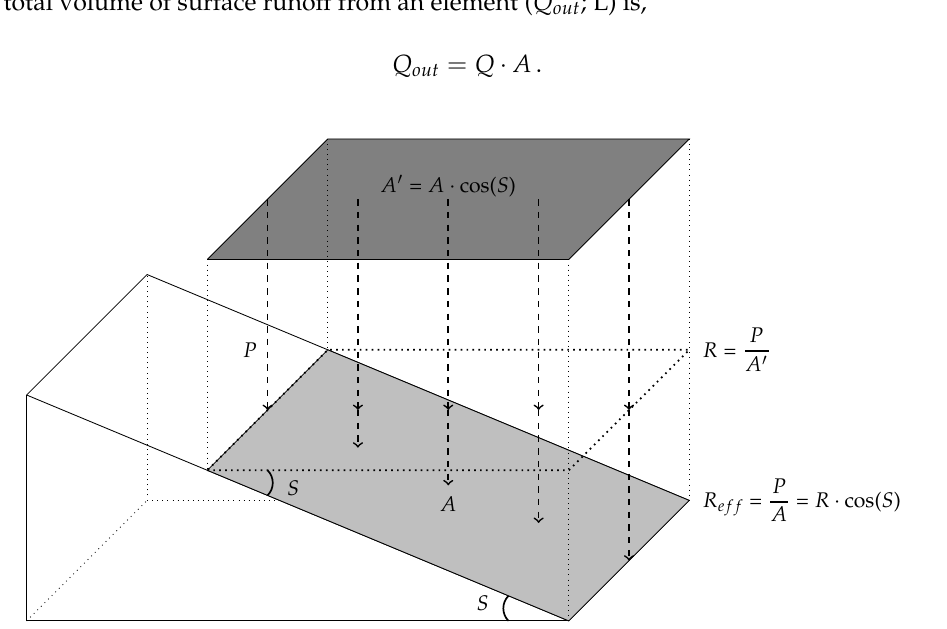
Figure 2. Conceptual representation of the effective rainfall ( R ef f ) on a slope element without permanent interception of rainfall (modified from Figure 1 of Choi et al. [39]). Given rainfall with a total volume of P , the amount of rainfall per unit area for both A (m 2 ) and A (cid:48) (m 2 ) is P / A and P / A (cid:48) which is equal to R . From the trigonometric rule, A , the projected area of A (cid:48) on the slope, is described as A (cid:48) / cos ( S ) . Therefore, the rainfall per unit surface area of the element (i.e., the effective rainfall) should be R cos ( S ) ·